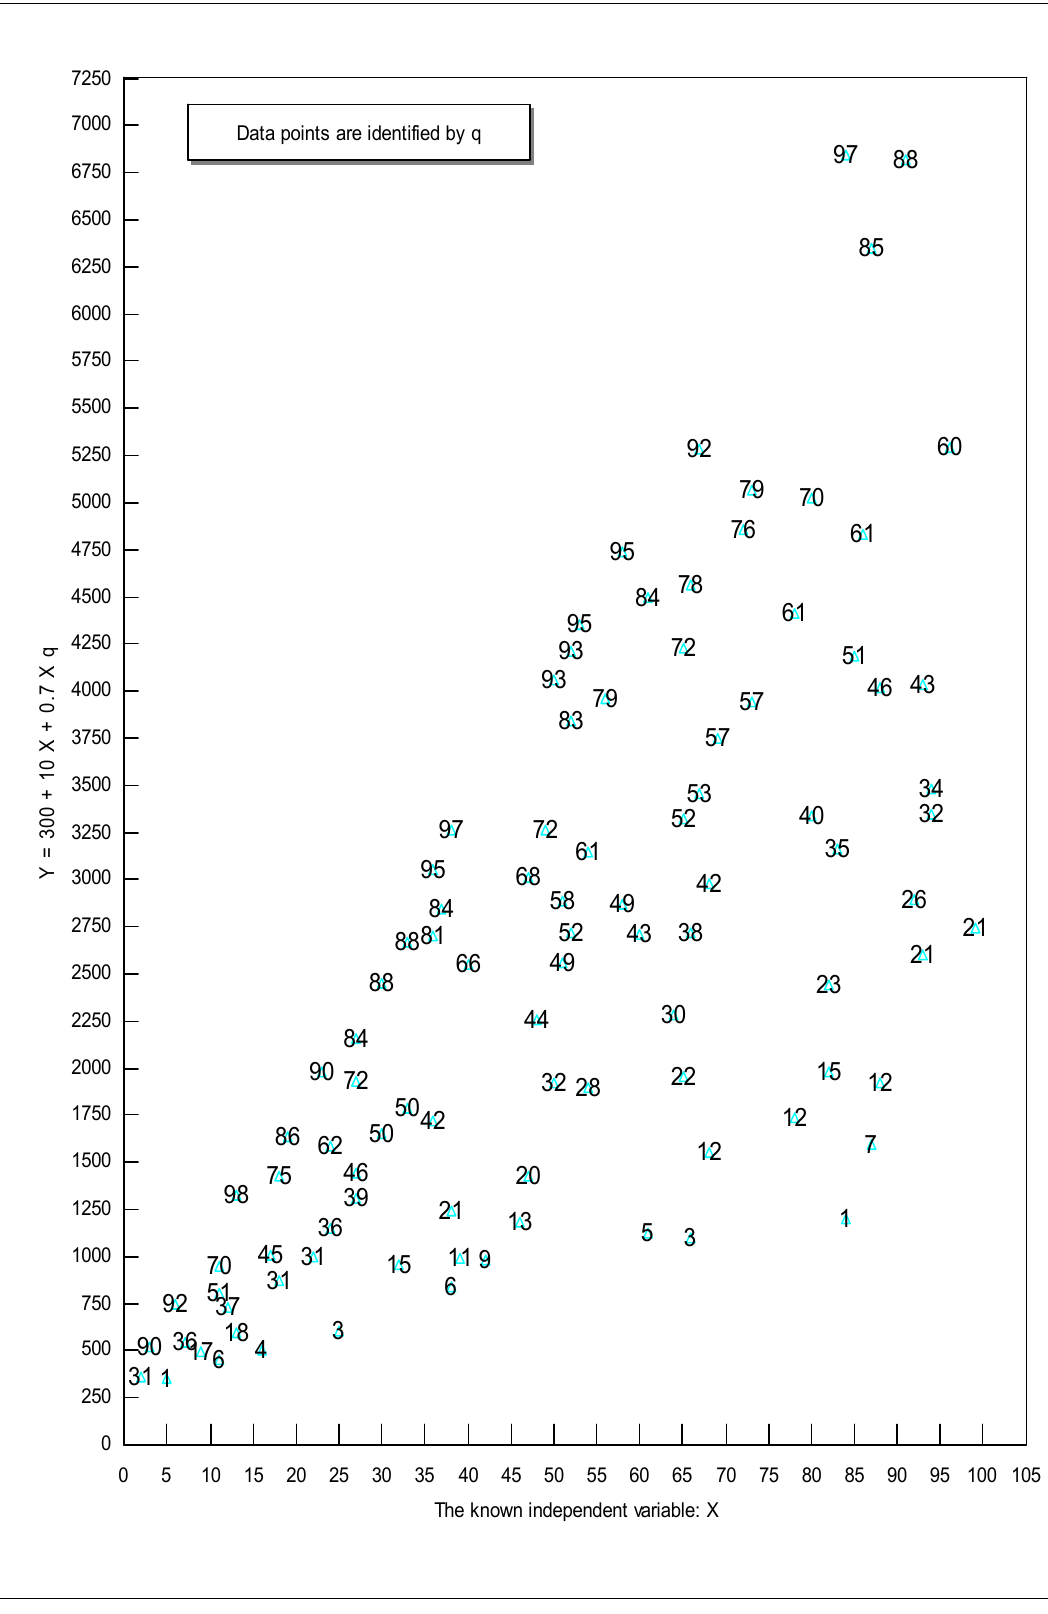
Figure 1. The Intuition behind RTPLS. RTPLS uses the relative vertical position of observations to capture the effect of omit- ted variables on estimated slopes. The RTPLS procedure starts by drawing a frontier